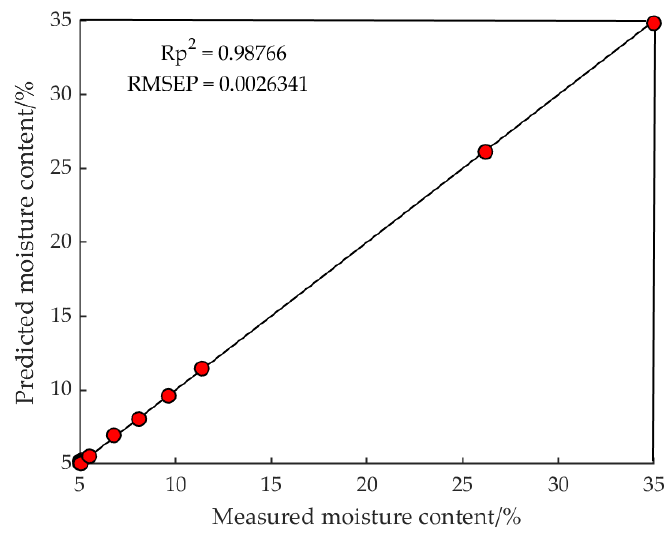
Figure 8. Predicted results of the moisture content of the PCA–SVR model.